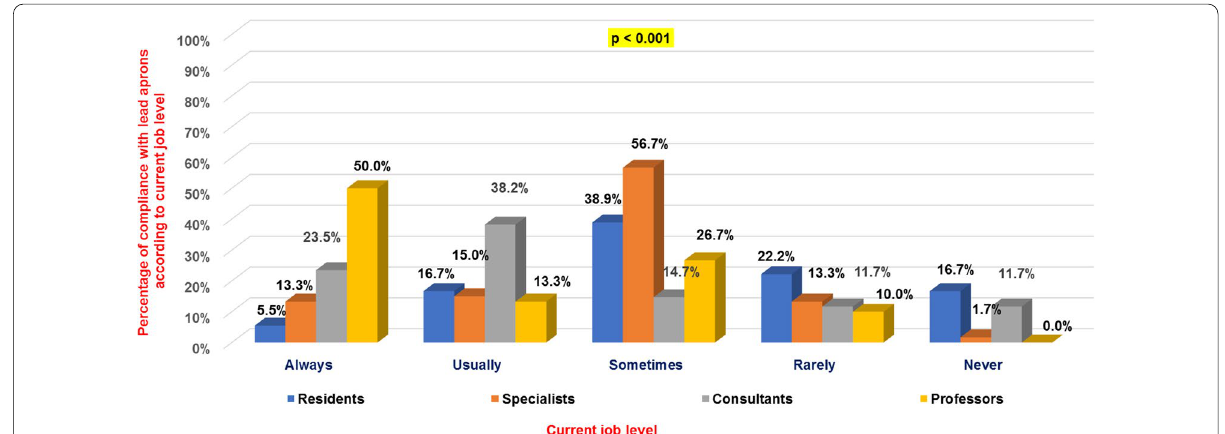
Fig. 3 Percentage of compliance with lead aprons according to the current job